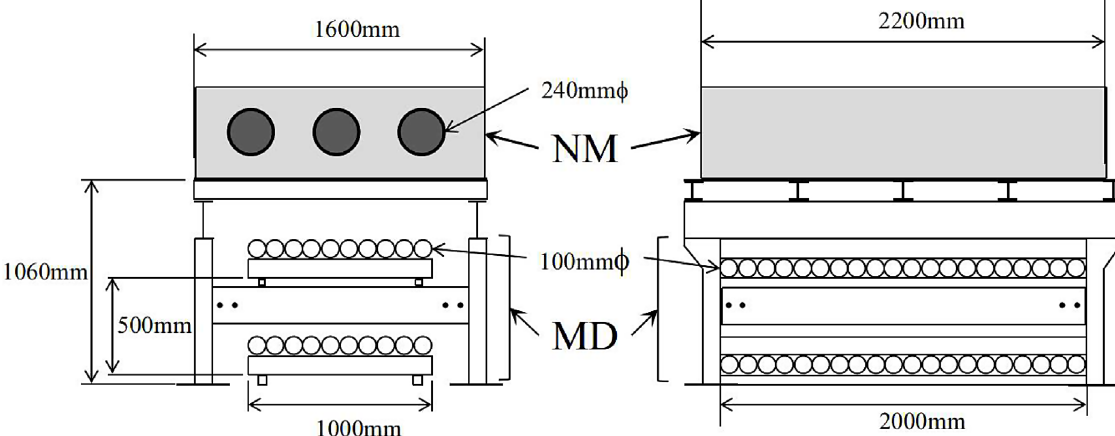
Fig. 2. Schematic view of detectors assembled on a steel frame in the container no. 2.